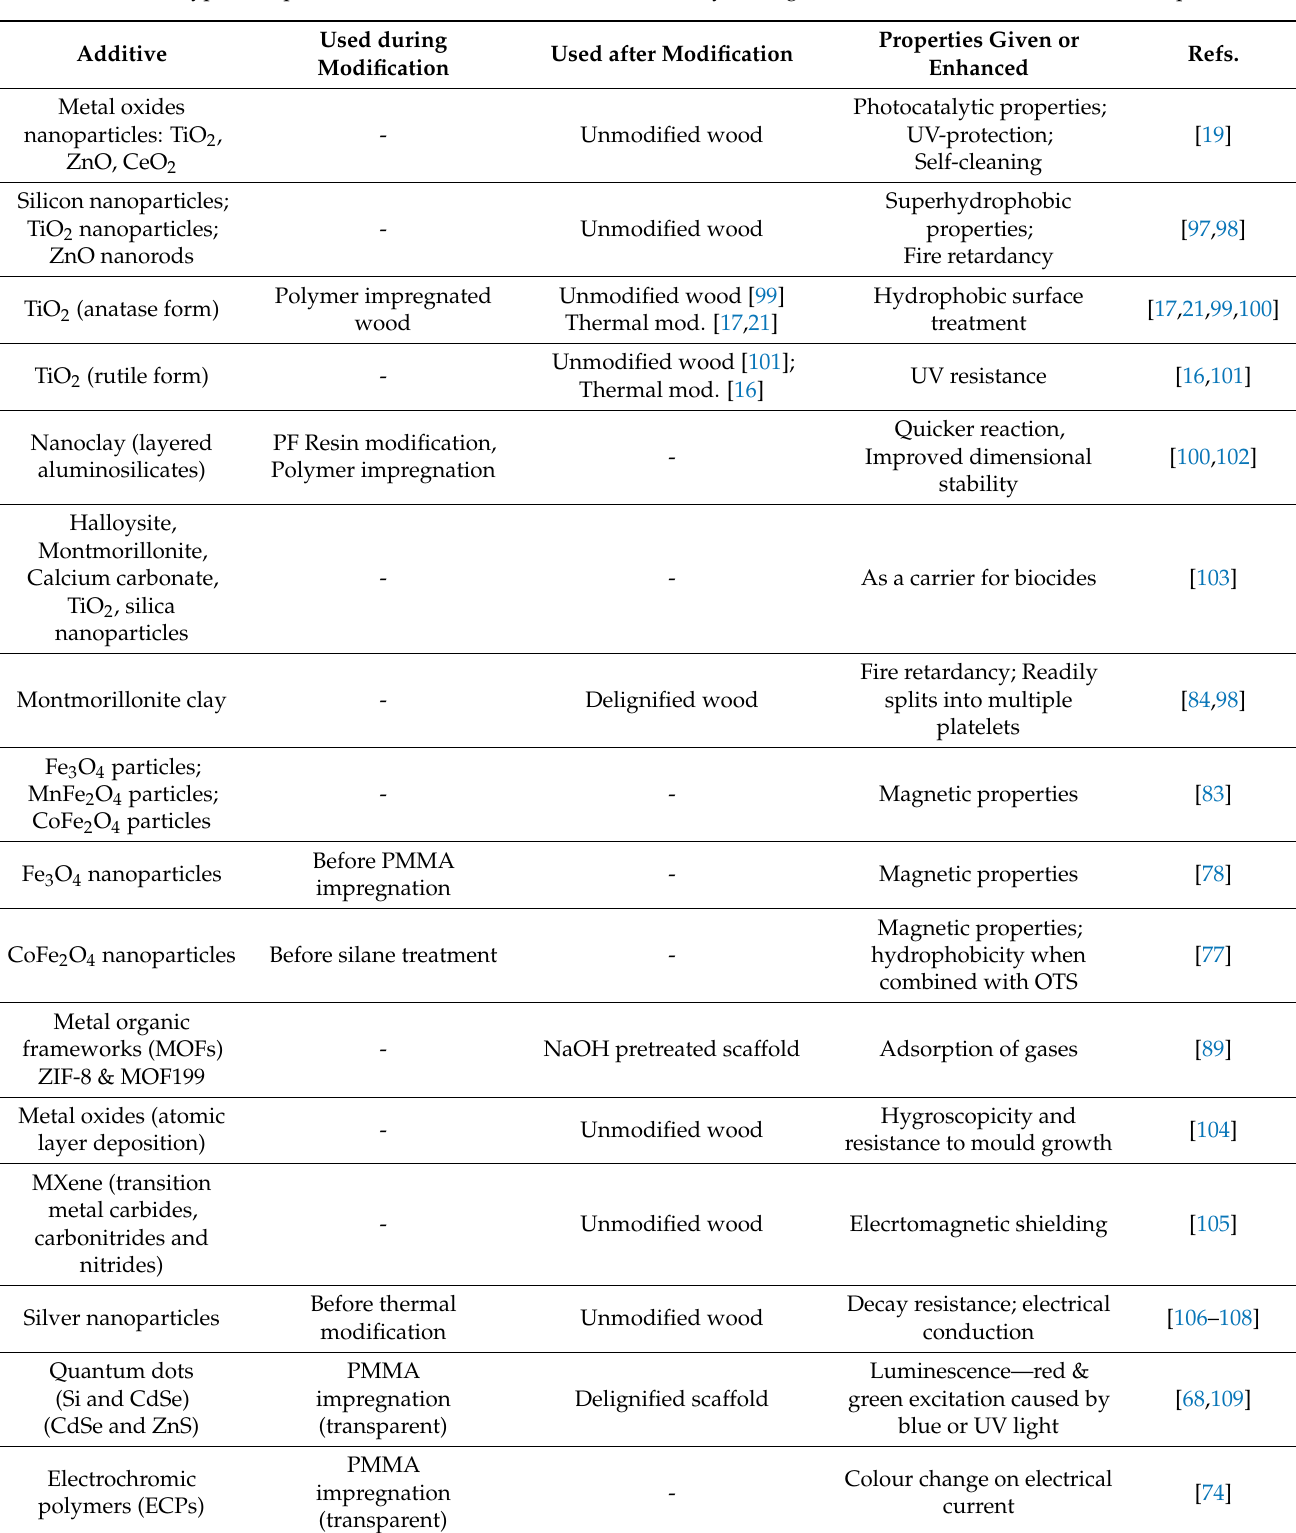
Table 3. Typical or potential additives used to add functionality during or after a main wood modification